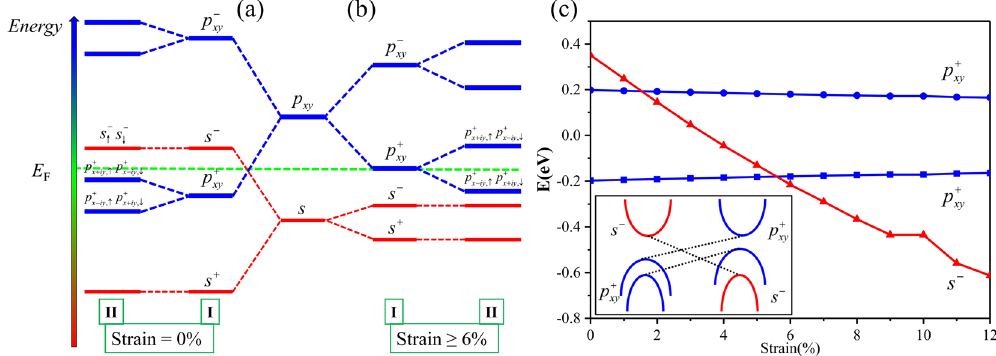
Figure 4. Schematic diagram of the evolution from the atomic s and p xy orbitals into the conduction and valence bands at the Γ point for SnCH 3 film ( a ) without strain and ( b ) with strain beyond 6%. The stages (I) and (II) represent the effect of switching on chemical bonding and SOC, respectively. The even and odd parities of Bloch states are denoted by + and - , respectively. ( c ) The relative energy levels of s and p xy orbitals at the Γ point for SnCH 3 film under different tensile strains, with a schematic representation shown in the inset. The center of the two separated p xy levels is defined as zero in